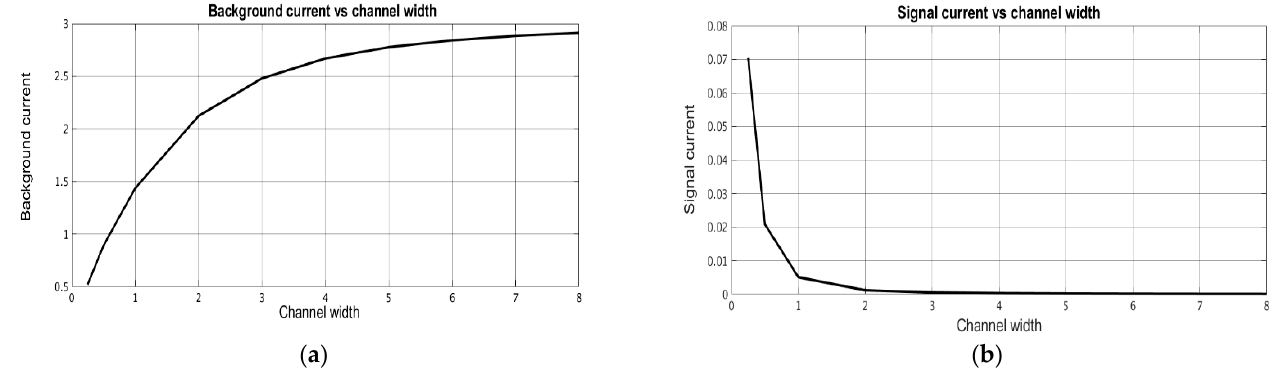
Figure 8. Dependence of ( a ) stationary background current and ( b ) signal current on dimensionless channel thickness.